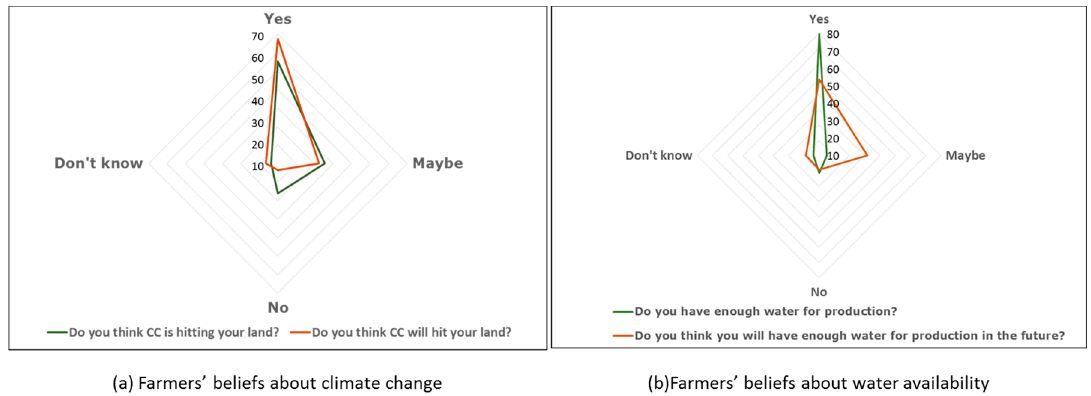
Figure 4. ( a ) Farmers’ beliefs about climate change; ( b ) farmers’ experience and belief about water availability, quantified by % responses for four levels: Yes, Maybe, No, I don’t know.